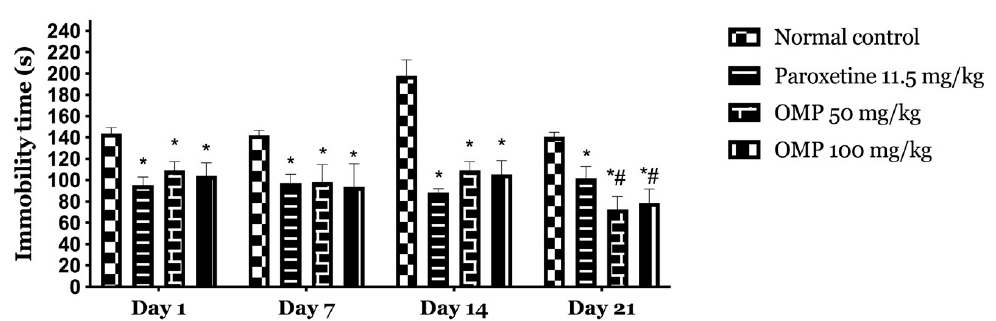
Figure 2. Temporal effects of OMP on immobility time in the forced swimming test (FST). Values are expressed as mean ± SEM. The analysis was done using two-way repeated-measures analysis of variance followed by the Tukey post-hoc test. ( * ) p < 0.001, compared with normal control; ( # ) p < 0.001, compared with paroxetine.